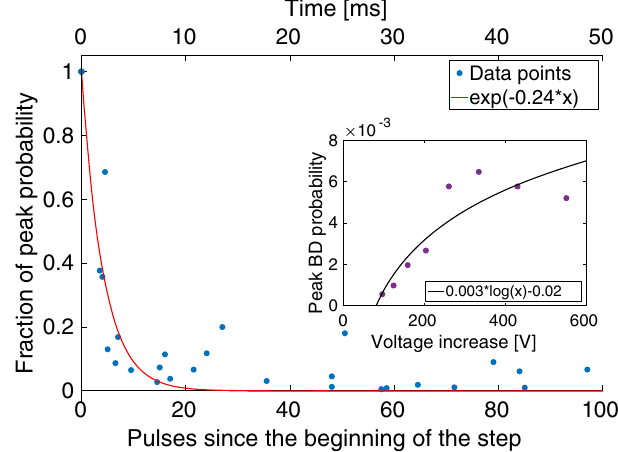
FIG. 6. Decay of BD probability as a function of pulses (or time) since the beginning of the ramping step. The red line shows an exponential fit on the data. The inset shows the relationship between the peak BD probability during a ramping step and the increase of voltage since the previous